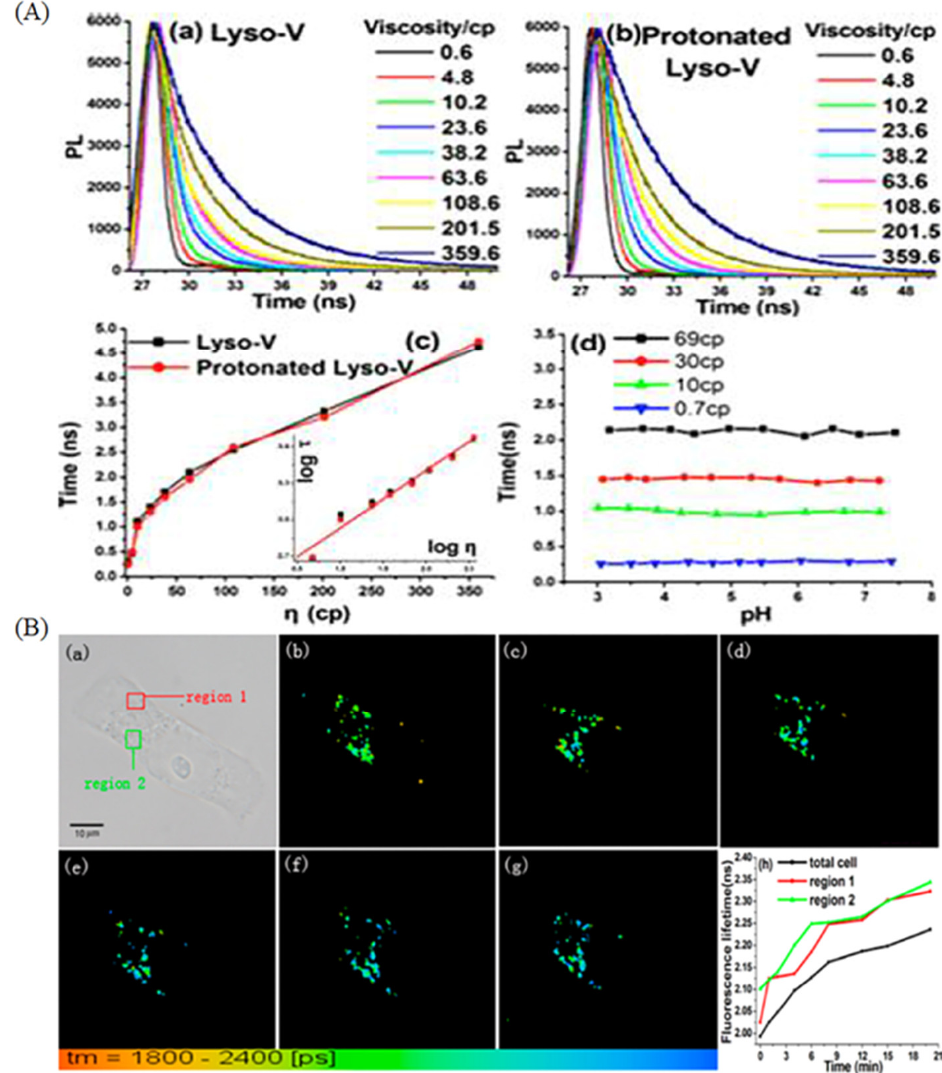
Figure 8. ( A ) Fluorescence lifetime spectra ( a ) of Lyso-V at the concentration of 2 µM and protonated Lyso-V ( b ) in at the concentration of 4 µM methanol/glycerol mixtures, and their Fluorescence lifetimes in diverse viscosity ( c ) and pH values ( d ). ( B ) Fluorescence lifetime imaging of Lyso-V in MCF-7 cells at diverse times after treatment with 5 µM dexamethasone and their corresponding fluorescence lifetimes. ( a ) DIC; ( b – g ). Fluorescence lifetime imaging at diverse time (0, 1, 2, 6, 8, 12 min). ( h ) the corrsponding fluorescence lifetime of different regins (1,2 and total cell) in diverse time. Reproduced from Ref. [52] with permission of the American Chemical Society, copyright 2013.